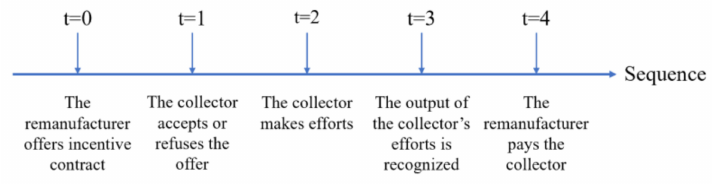
Figure 2. The sequence of the incentive